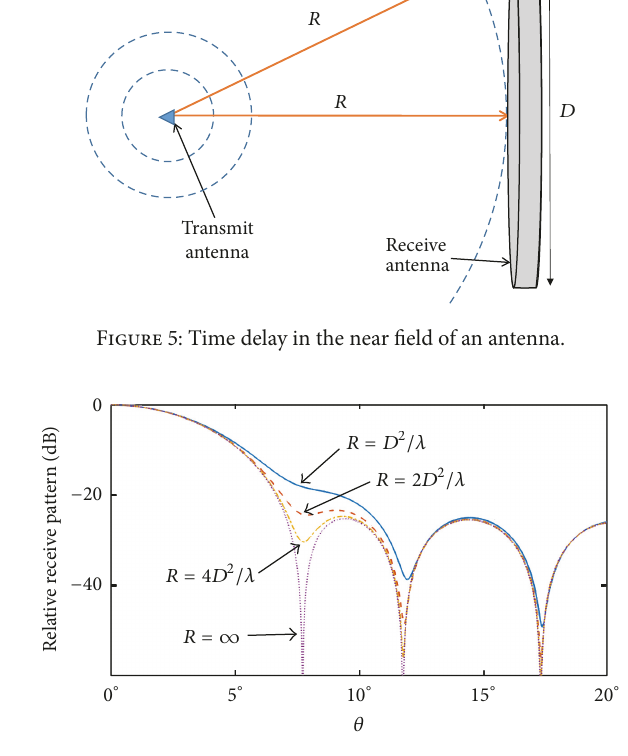
Figure 6: Far field patterns as a function of separation distance between the transmit and receive